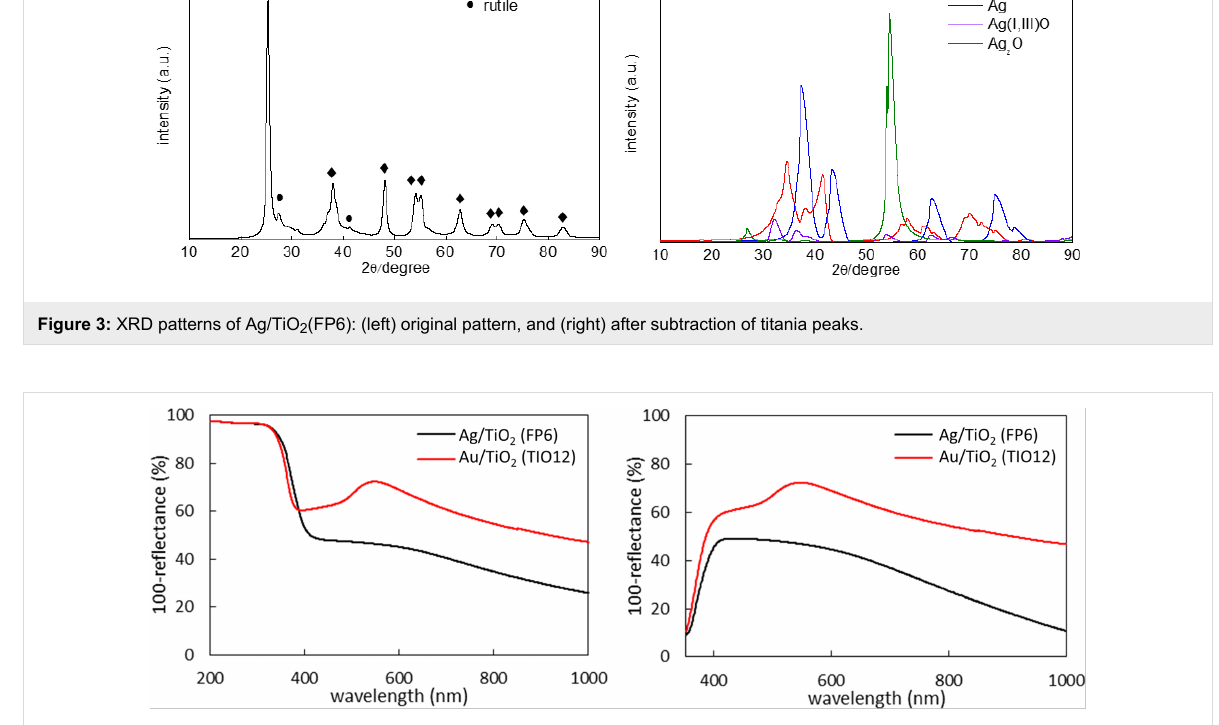
Figure 4: DRS spectra of Ag/TiO 2 (FP6) and Au/TiO 2 (TIO12) taken with BaSO 4 (left) and respective bare titania (right) as a reference.